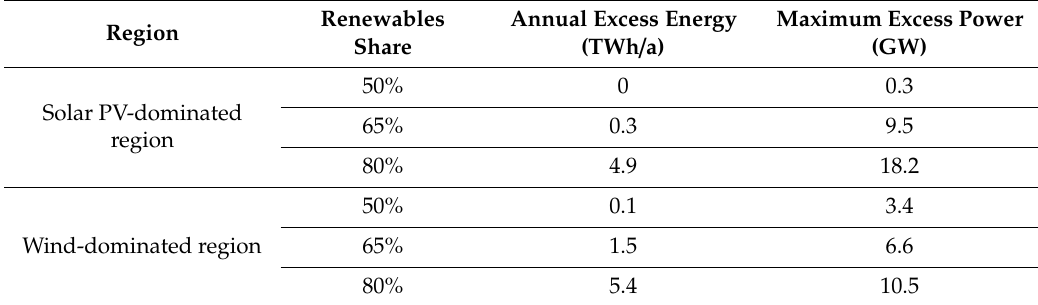
Table 3. Remaining excess energy and power after covering of residual load in CLASSIC scenarios. Renewables Region share